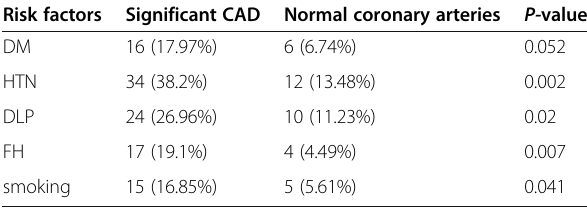
Table 3 Frequency of coronary risk factors in patients with and without CAD